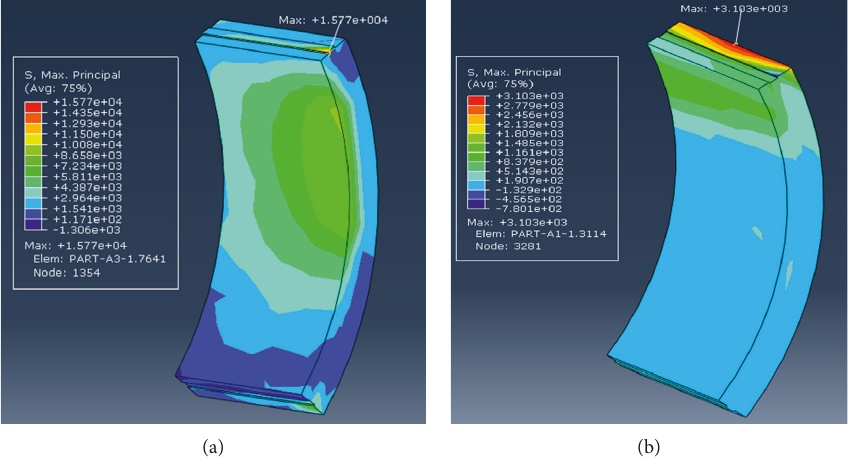
Figure 13: The effect of water head difference on the maximum tensile stress of segment. Water head difference of (a) 18 m and (b) 0 m.